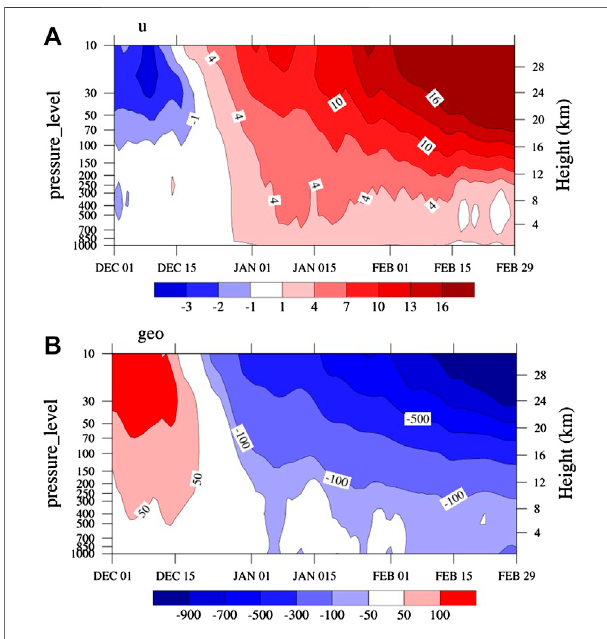
FIGURE 8 | Time-altitude cross-sections of (A) the zonal mean zonal wind anomalies along 60 ° N (units: m/s) and (B) the zonal mean geopotential height anomalies along 70 ° – 90 ° N (units: m) over the Northern Hemisphere from Dec 2019 to Feb 2020.